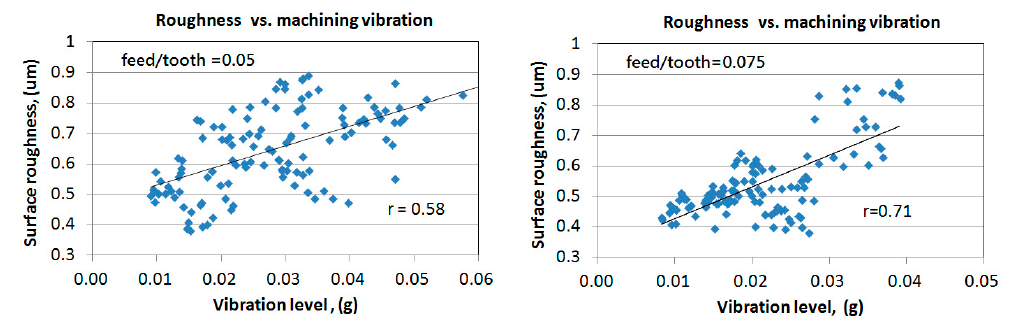
Figure 11. Correlation between surface roughness and machining vibration level.